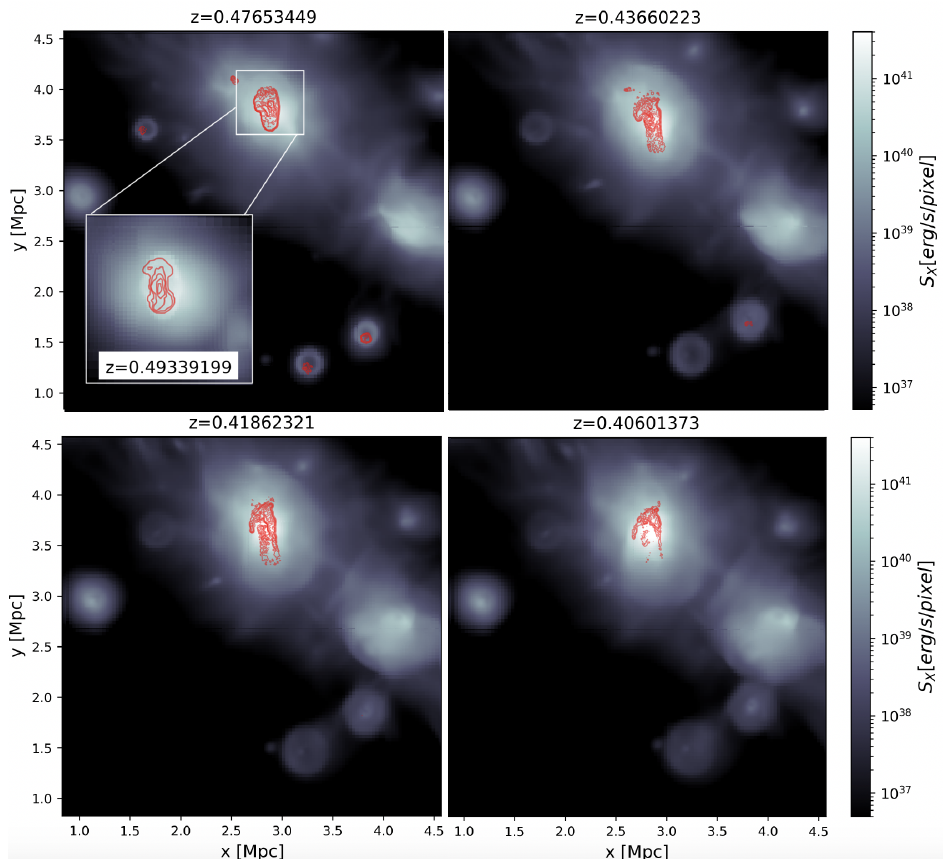
Figure 3. Evolution of the X-ray surface brightness (in the 0.5–2keV energy range, grey colours) and of the radio emission at 50 MHz with LOFAR LBA, for all electrons seeded by radio jets at z = 0.5 and later re-accelerated by shocks and turbulence (CST model, red contours, equally spaced by and starting from 2 σ , where σ is the assumed LOFAR LBA sensitivity (see Section 3.1) for details). The inset in the first panel shows a zoom onto the most powerful radio galaxies at an earlier redshift, i.e., ∼ 64 Myr since the injection of jets. The sequence continues in Figure 8 and the full movie can be watched at https://youtu.be/MPEFiIzr-V8 (accessed on 17 February